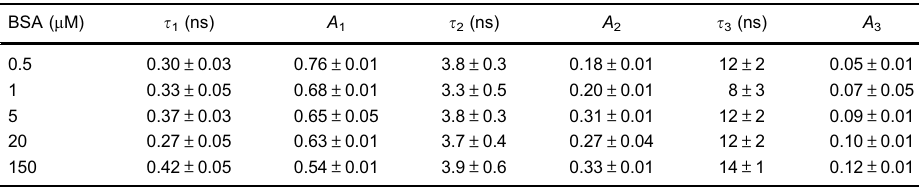
Figure 6. Optical absorption ( A ), fl uorescence spectra ( B ) ( l ex=420 nm), and fl uorescence decay curves ( C ) of 1.7 m M synthetic protoporphyrin IX (PpIXs) at pH 4.5 for different bovine serum albumin (BSA) concentrations ( l ex=420 nm, l em=628 Table 3. The average values of lifetimes ( t i ) of the fl uorescence decay components of PpIXs and their relative contents ( A 1 , A 2 and A 3 ), calculated in accordance with the equation (Eq. 4) at pH 7.3 for different BSA concentrations.